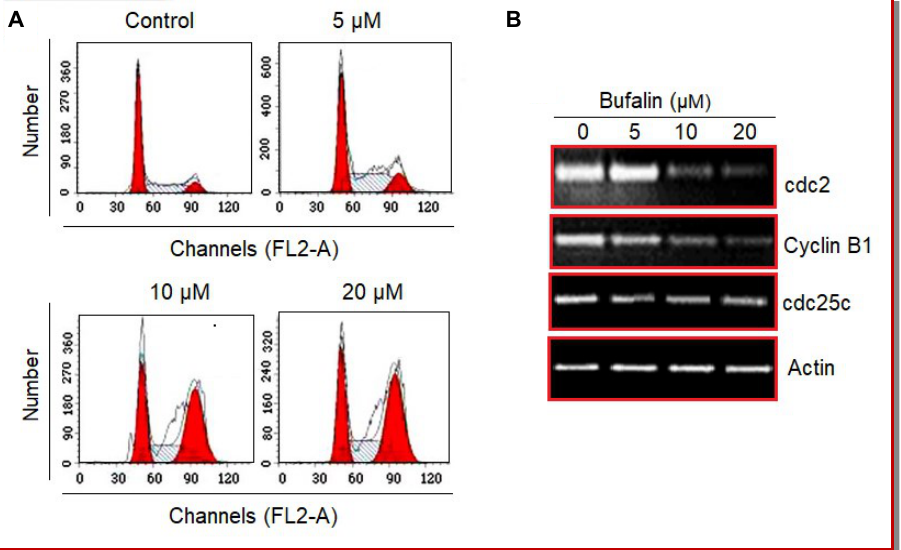
Figure 2: G 2 /M phase mitotic arrest is induced in bufalin treated gastric cancer cells. (A) Analysis of cell cycle phase distribution of MGC-803 cancer cells through flow cytometry incubated without or with 5, 10 or 20 µM bufalin at 37 º C for 24 hours; (B) relative expression analysis of cdc2, cyclin B1 and cdc25c cell cycle regulatory proteins form MGC-803 cancer cells through flow cytometry incubated without or with 5, 10 or 20 µM bufalin at 37 º C for 24 hours. Each experiment was performed with three